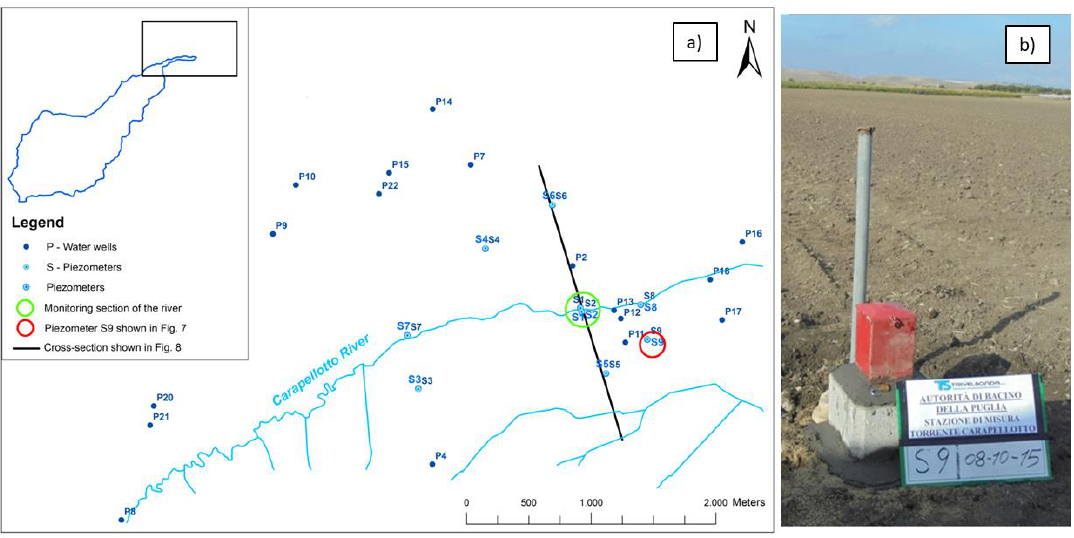
Figure 6. ( a ) Setting of the groundwater monitoring network. ( b ) Example of a groundwater monitoring well.